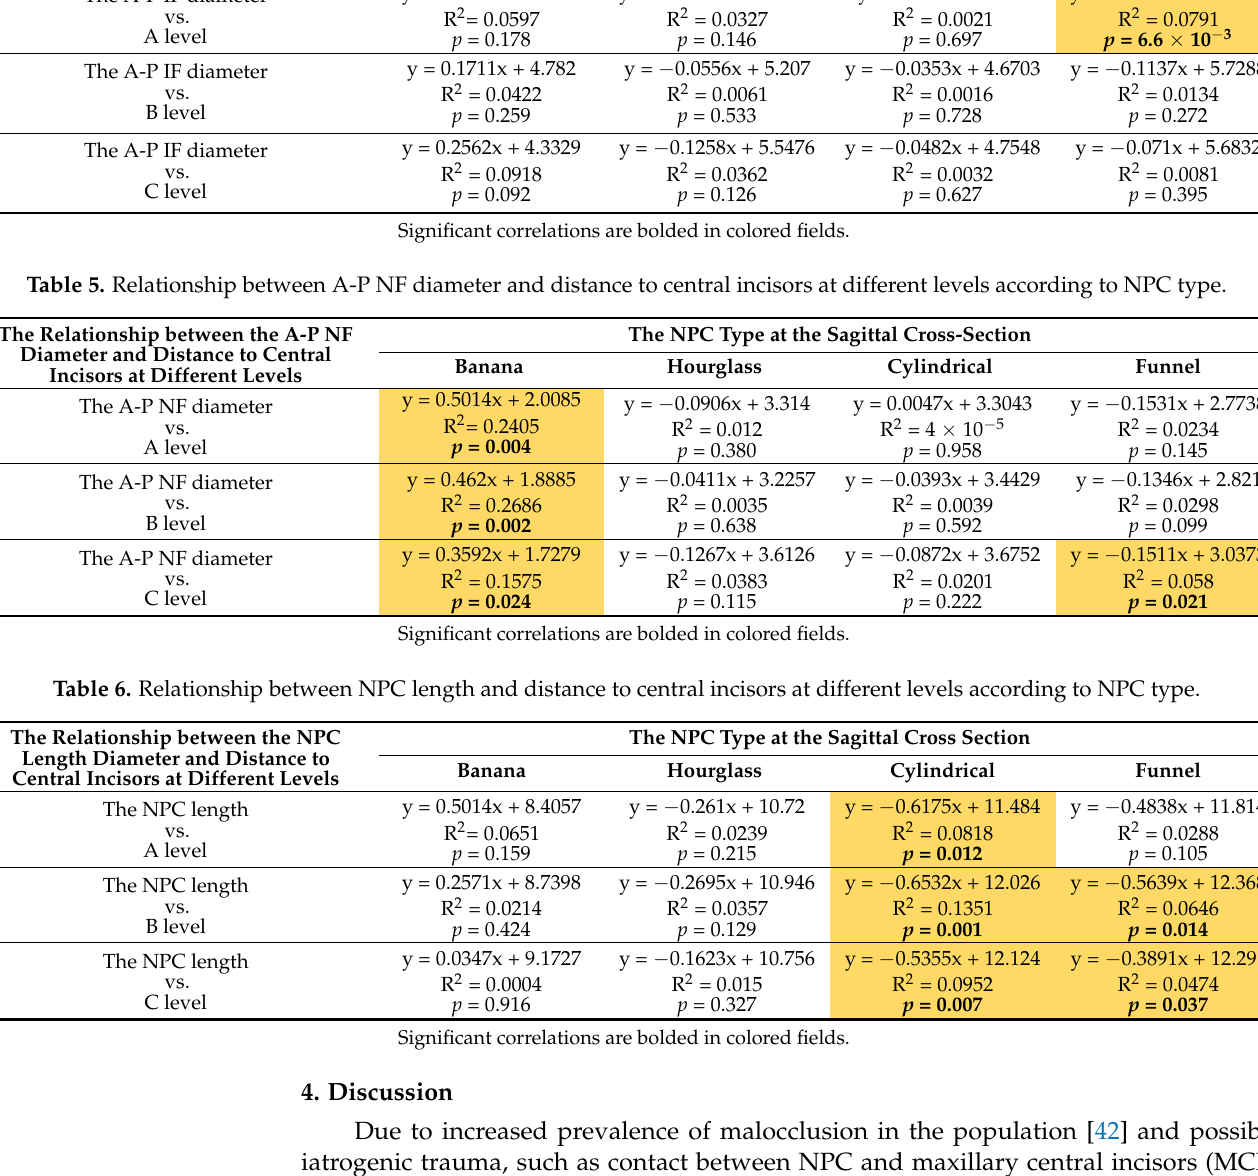
Table 4. Relationship between A-P IF diameter and distance to central incisors at different levels according to NPC type. The NPC Type at the Sagittal Cross-Section The Relationship between the A-P IF Diameter and Distance to Central Banana Hourglass Cylindrical Funnel Incisors at Different Levels